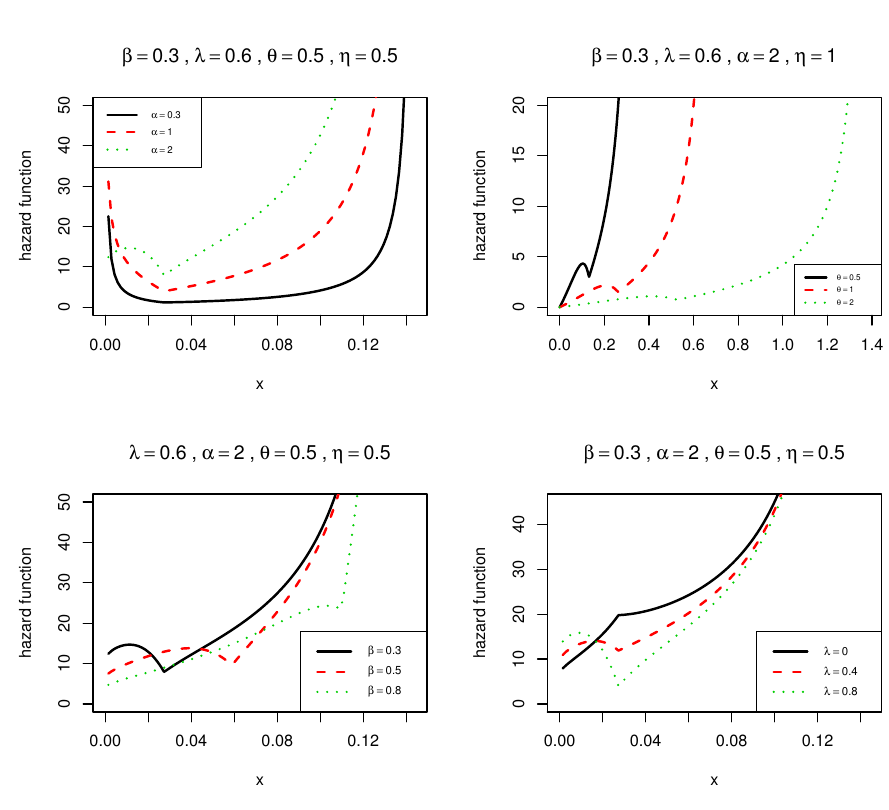
Figure 4 – The graphs of the hazard function of the GOTTS-E distribution with − 1 ≤ λ ≤